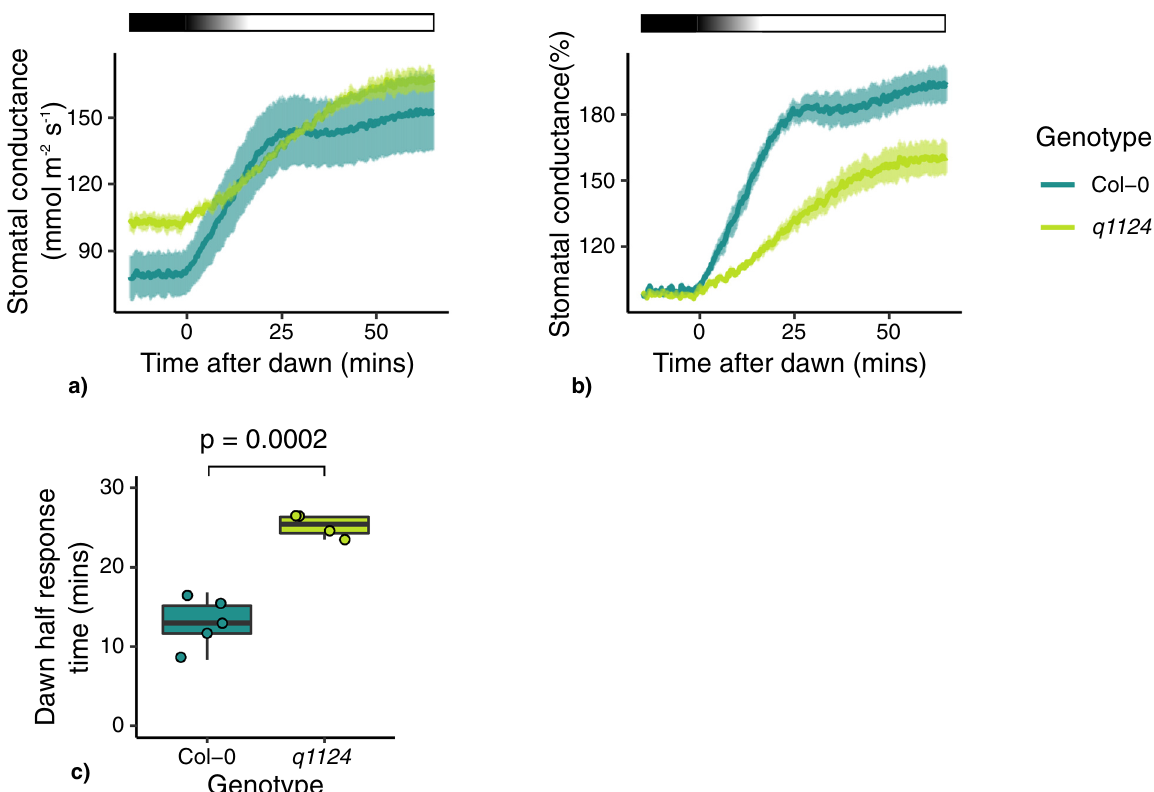
Figure 6. q1124 stomatal conductance responses at dawn. Stomatal conductance of the q1124 quadruple ABA receptor over the dawn transition period. On the onset of dawn, the lights were turned on over a 15 min period until reaching full brightness. ( a ) Absolute and ( b ) relative stomatal conductance values are presented as the mean ± s.e.m. ( c ) The time taken to reach half of the maximum stomatal conductance change (half response times) upon dusk are presented in boxplots showing the median and interquartile ranges. 4–5 plants measured per genotype. Light treatment is represented above each plot, with black boxes representing darkness and white boxes representing light. A gradient represents the 15 min transition from darkness to